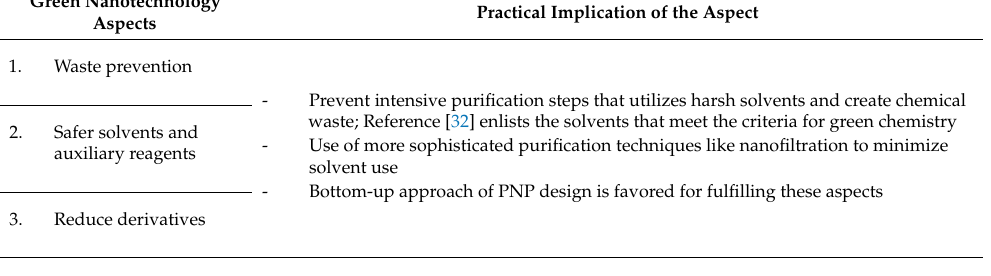
Table1. Majoraspectsofgreennanotechnologyandtheirpracticalimplicationsforpolymernanoscience. Green Nanotechnology Practical Implication of the Aspects